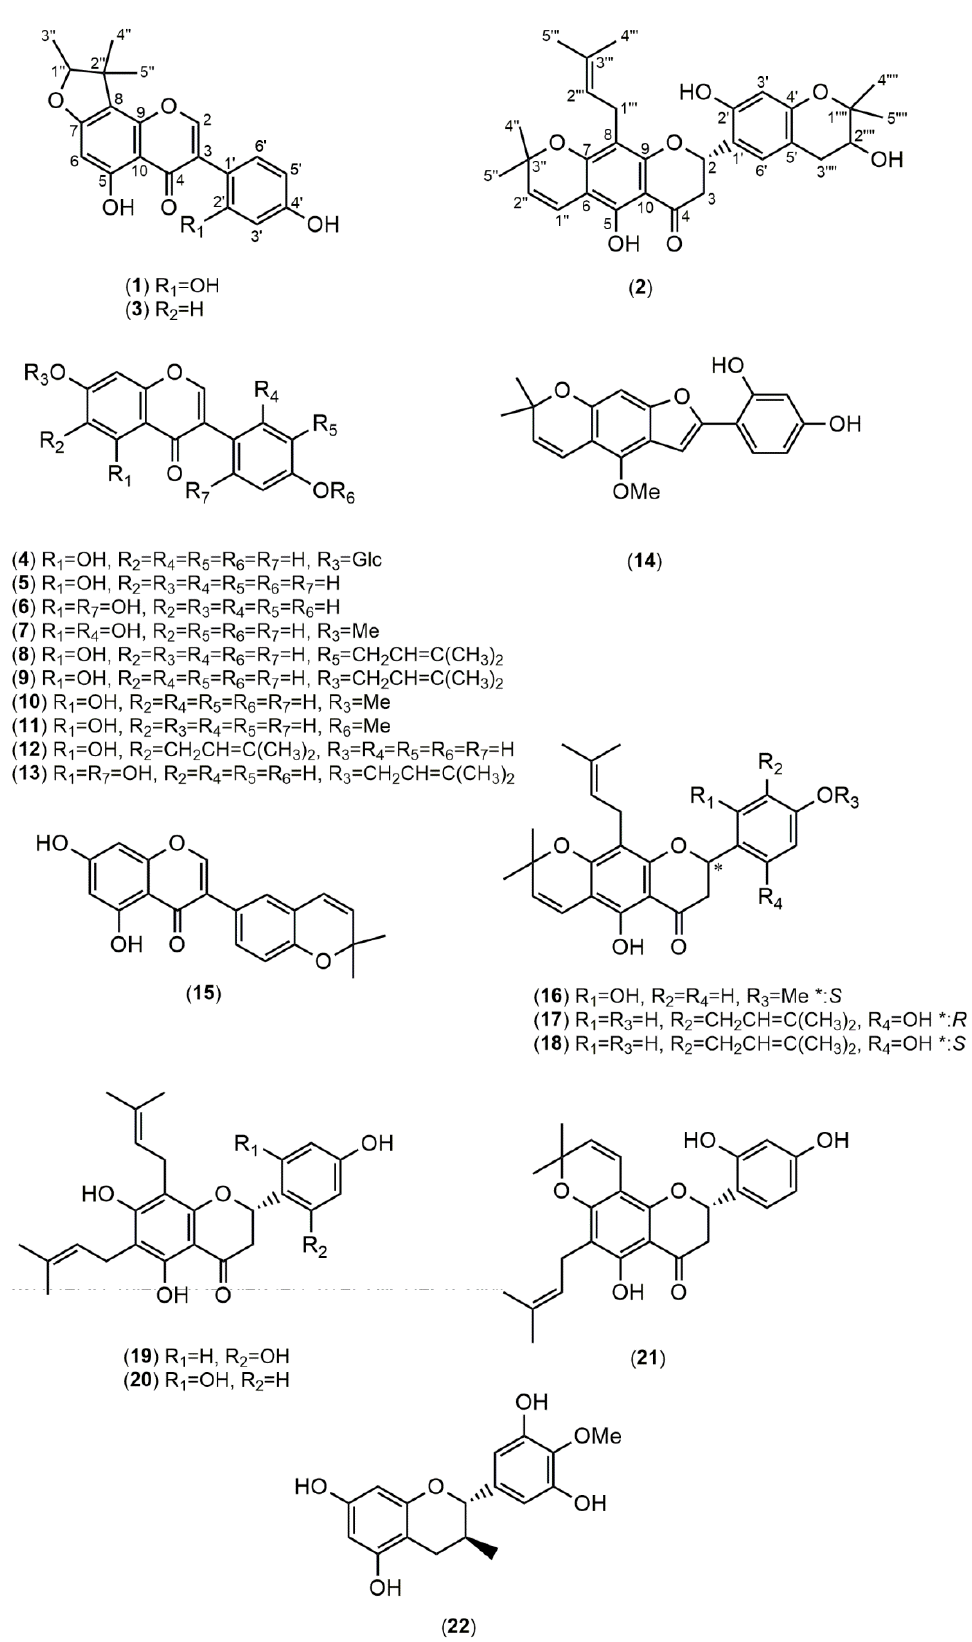
Figure 1. Structures of the isolated compounds from F.